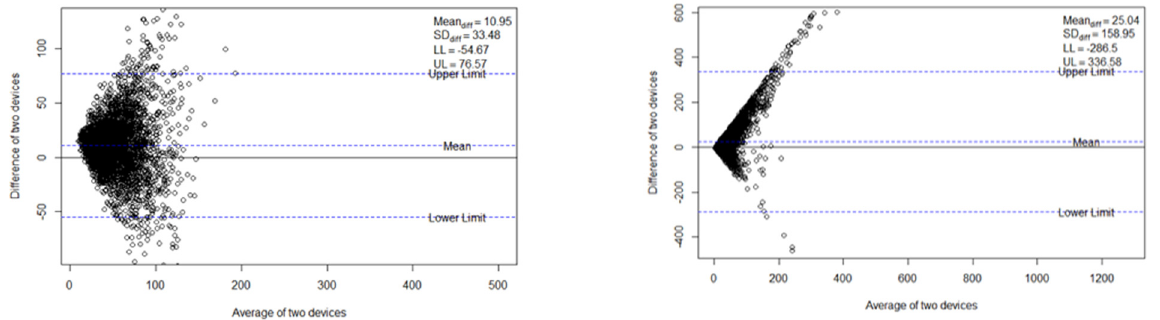
Figure 9. Bland–Altman test of agreement plot between US MET One BAM and MA3 PurpleAir Device in Kampala, Uganda ( left ) and in Khartoum, Sudan ( right ).